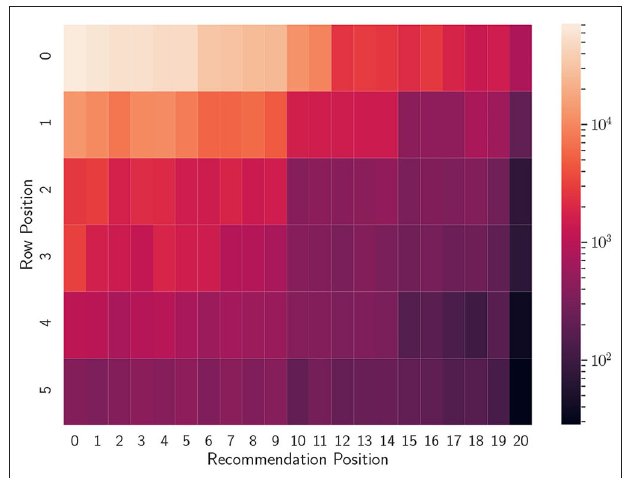
FIGURE 3 | Heatmap of the number of interactions per position on the screen, taken from the dataset presented in Pérez Maurera et al. (2020).